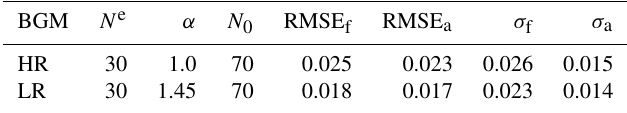
Table 2. Ensemble size ( N e ), inflation factor ( α ) and initial mesh size ( N 0 ) chosen from the sensitivity experiments in Fig. 8 to perform the experiment in Fig. 9. Resulting time mean of the RMSE and spread ( σ ) in for the HR and LR using BGM between t = 0 and t = 2 are also listed.